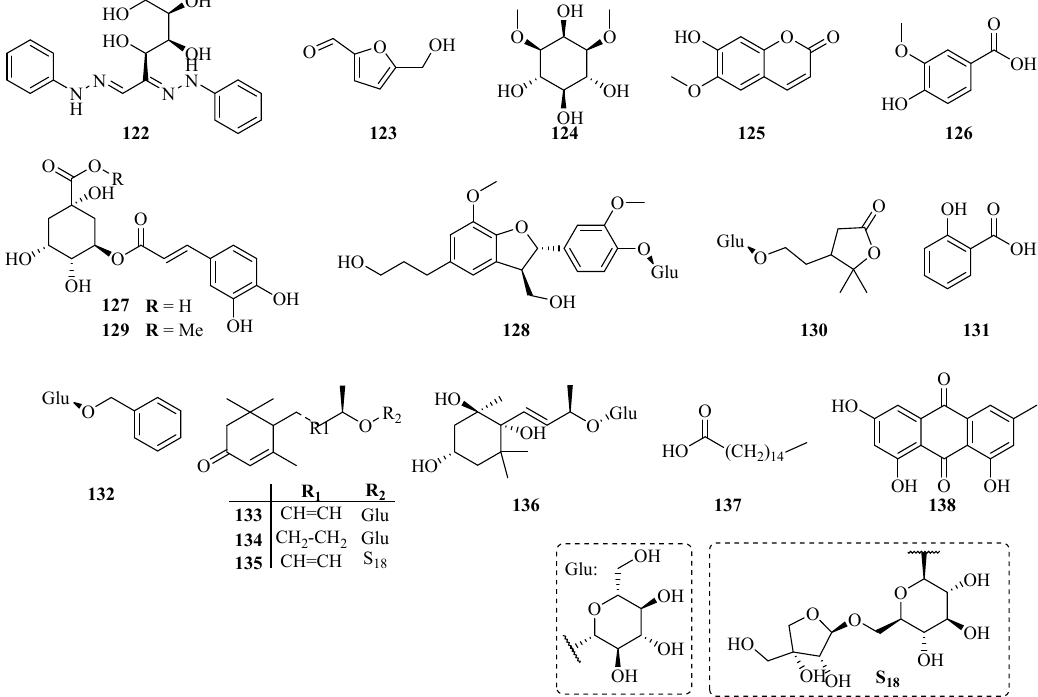
Figure 6. Other compounds from the Trachelospermum plants.